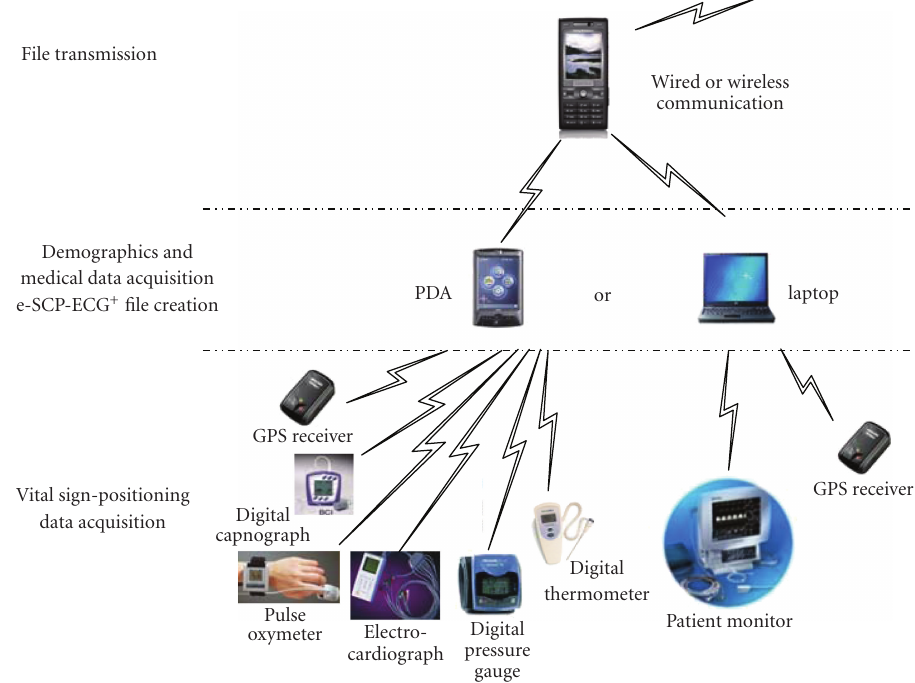
Figure 10: Overview of data acquisition, file preparation, and transmission.